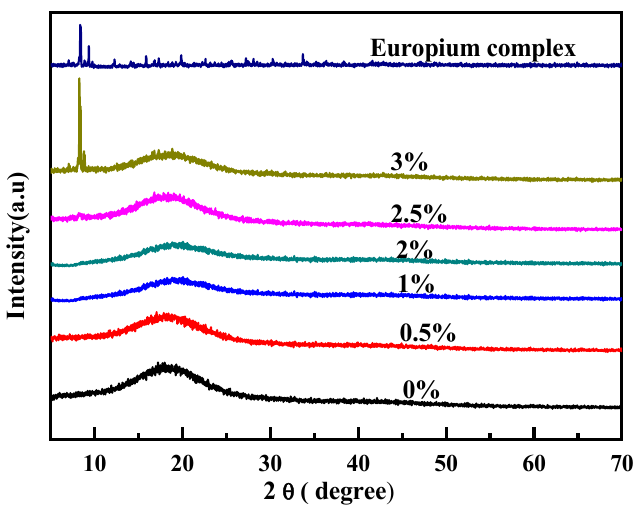
Figure 2. XRD patterns of the europium complex and polyurethane–europium materials with different mass contents of europium complex.